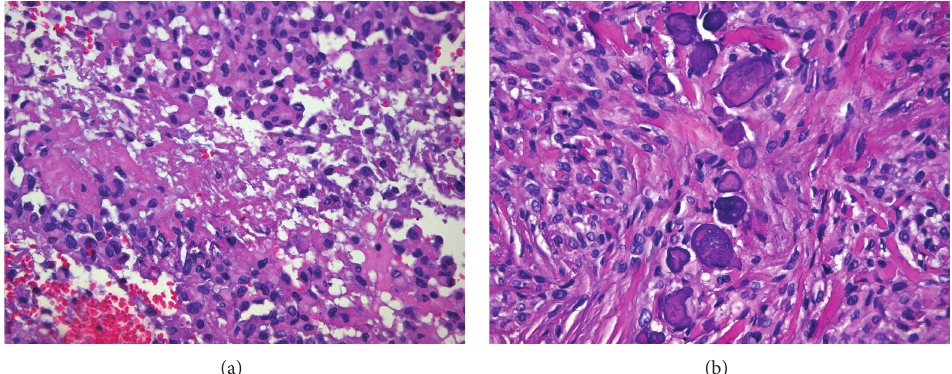
Figure 2: (a) Epithelioid cells with eosinophilic cytoplasm arranged around central necrosis (H&E, × 200). (b) Spindle cells with focal microcalcifications (H&E, × 200).